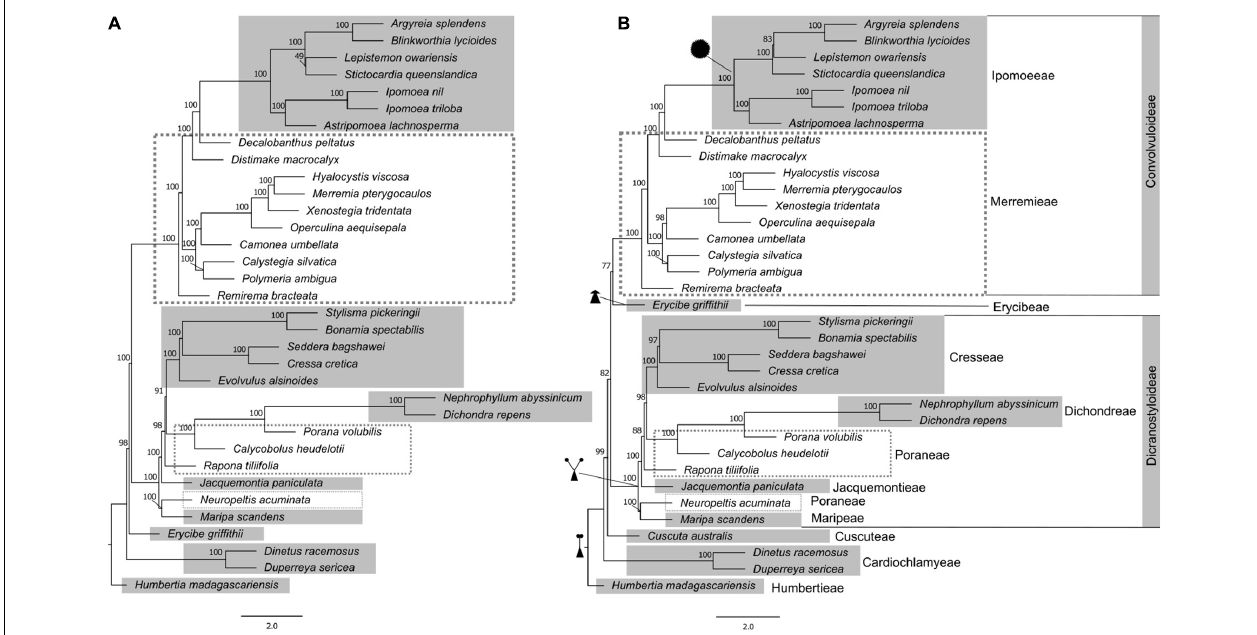
FIGURE 1 | Phylogeny of Convolvulaceae with different dataset composition estimated in ASTRAL-III, exploring the impact of the inclusion of Cuscuta in the coalescent analyses. (A) without Cuscuta ; (B) with Cuscuta . Tribes are indicated, and known synapomorphies for the major clades are illustrated: single style, assumed plesiomorphic for the family; “bifid style”, shared by the Dicranostyloideae clade including tribes Dichondreae, Poraneae, Jacquemontieae, and Maripeae; the lack of a style (sessile stigma) in Erycibeae; and spiny pollen, supporting tribe Ipomoeeae. Node support was assessed by multilocus bootstrapping in ASTRAL-III. ASTRAL-III only estimates internal branch lengths, which are in coalescent units; all terminal branch lengths are set to be